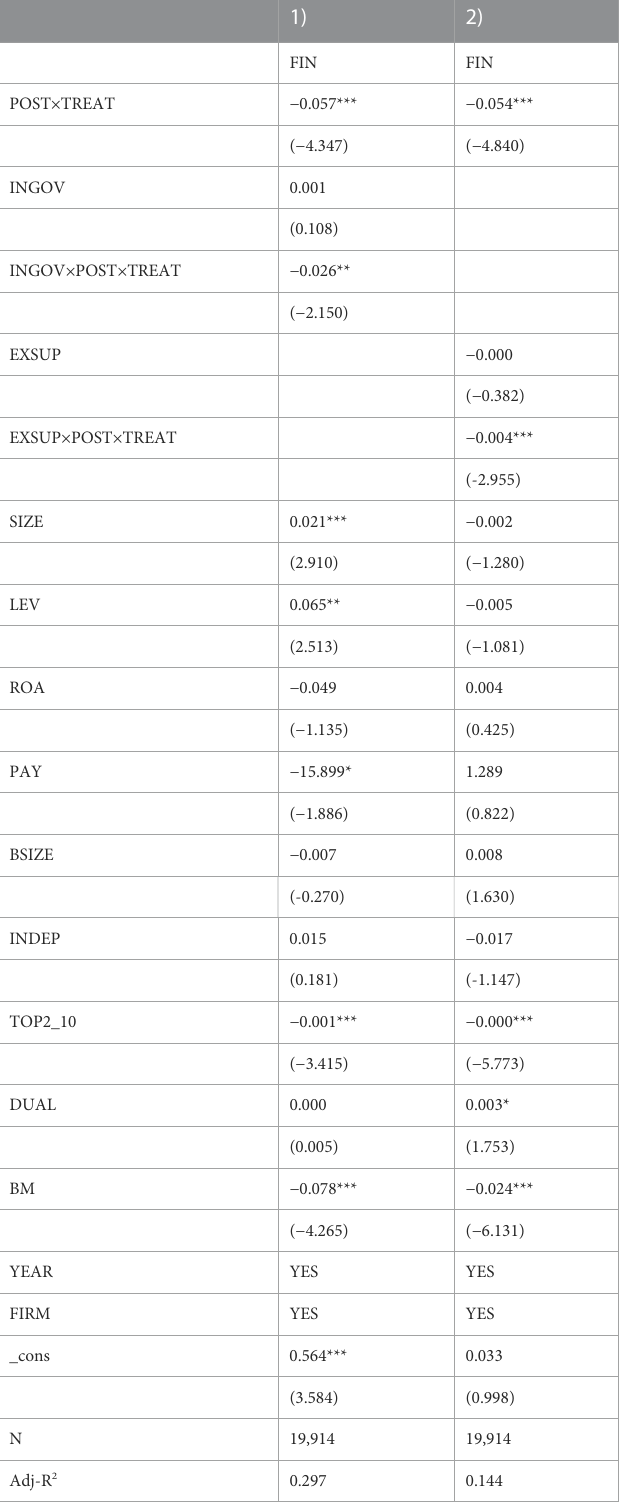
TABLE 11 Interaction